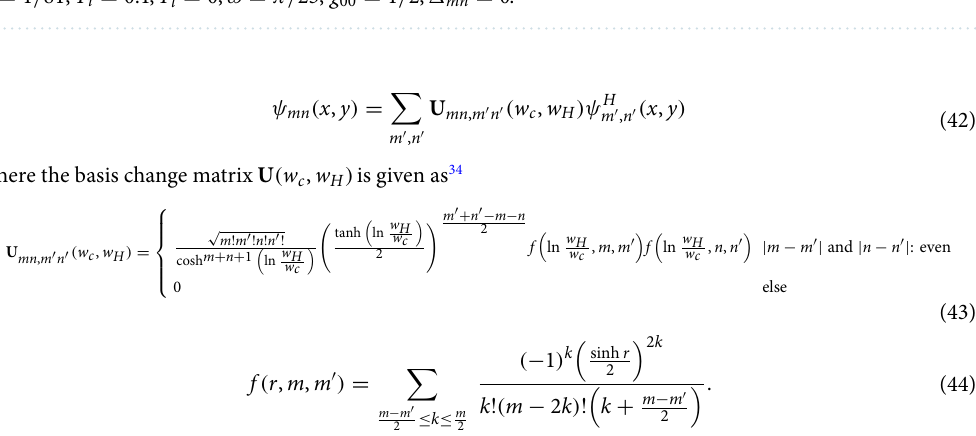
Figure 7. ( a , b ) Effect of mode mismatch due to difference in the cavity waist ( w c ) and the interaction 1.4 w c , solid blue) is Hamiltonian waist ( w H ). The squeezing level due to a large difference in waists ( w H = w c , solid red) and with the single-mode 9.5-dB compared with the case of no difference in waists ( w H = squeezed light (black dot dashed). ( c , d ) Effect of the Gaussian approximation (4) for the original interaction Hamiltonian (2,46). The solid lines are for the original Hamiltonian and the dashed lines are for the Gaussian approximation, which are plotted without a Gouy phase (blue) and with a Gouy phase (red). Black dot- dashed line is for the single-mode 9.5-dB squeezed light. We use the following parameters for the plots: (cid:31) mn ξ ω π/ 25 , 1 / 2 , 0 1 / 81, T i 0.1 , T l 0 , g 00 ˜ ˜ = = = = ˜ = =